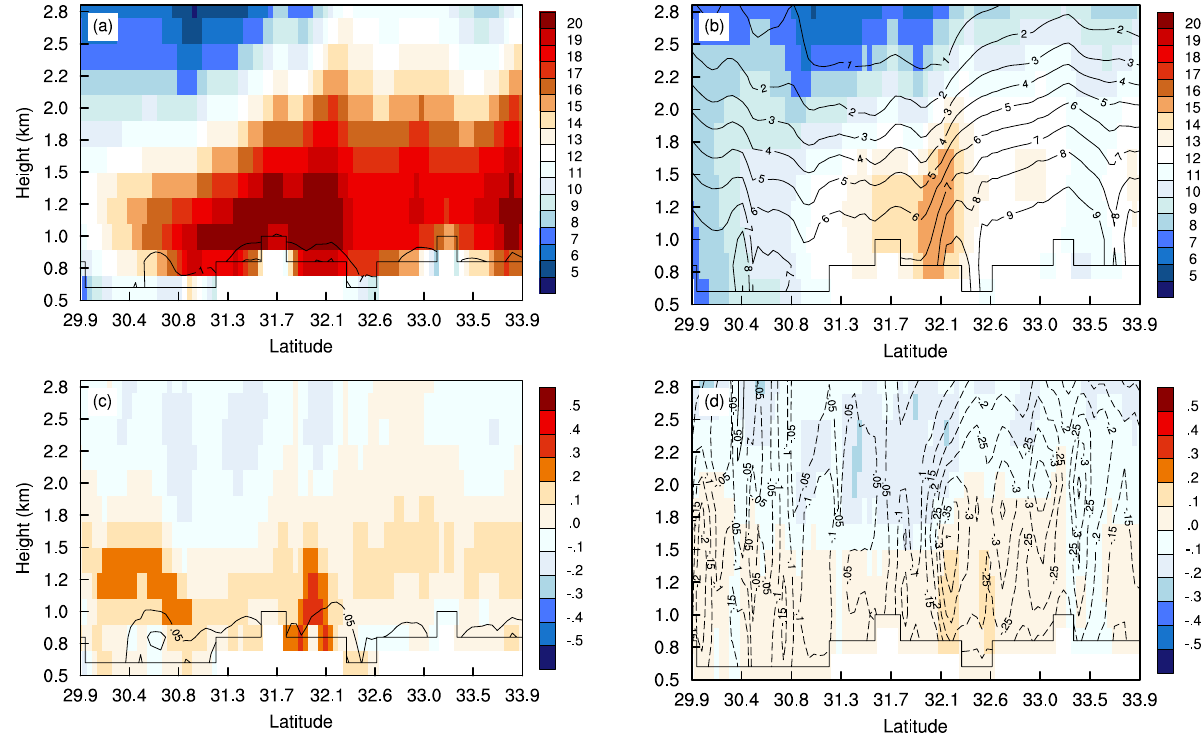
Fig. 4. Vertical cross sections (from A to B in Fig. 3a) of horizontal wind speed (colours, ms − 1 ) and turbulent kinetic energy (contour interval of 1m 2 s − 2 ) from the simulation that included the direct radiative forcing ( a and b ). The difference between simulations with radiative forcing on and off are shown in (c) and (d) (same variables as top panels, but contour interval of 0.05m 2 s − 2 for turbulent kinetic energy). The left panels ( a and c ) are for nighttime (21:00 local time) and the right panels ( b and d ) are for daytime (12:00 local